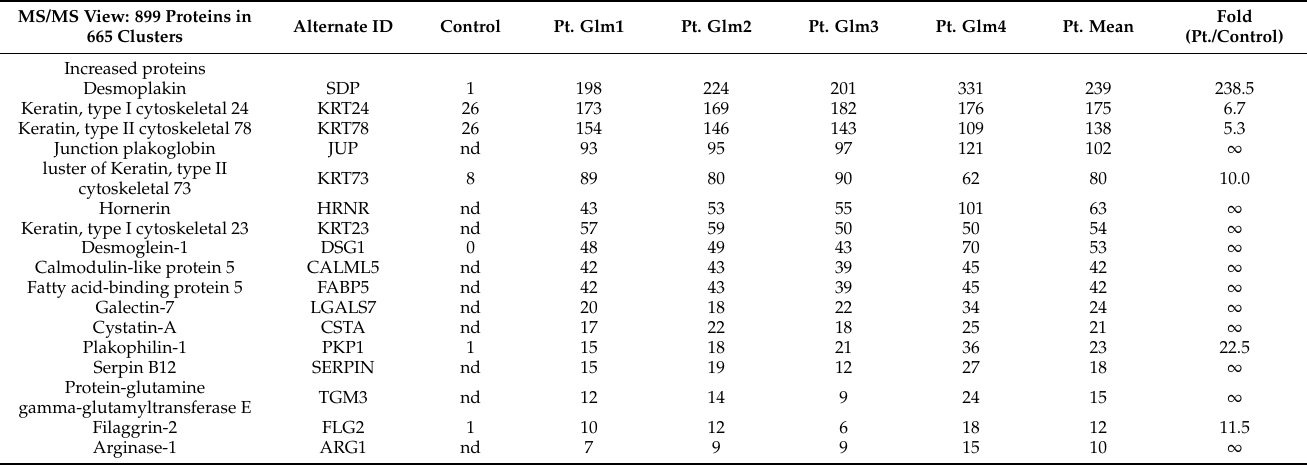
Table 1. Laser microdissection mass spectrometry analysis of glomeruli of this patient and glomeruli from the 1 h renal biopsy after renal transplantation as control.